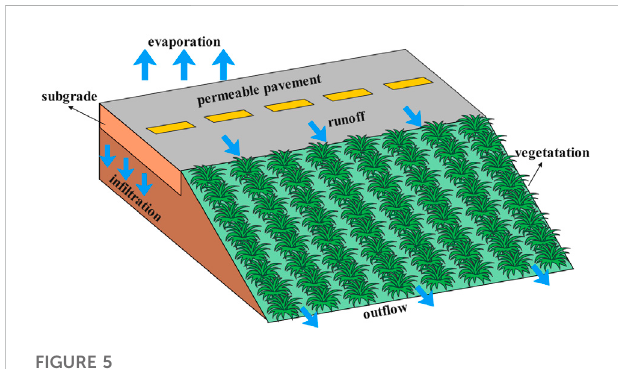
FIGURE 5 Speci fi c structure of the vegetation buffer strand.